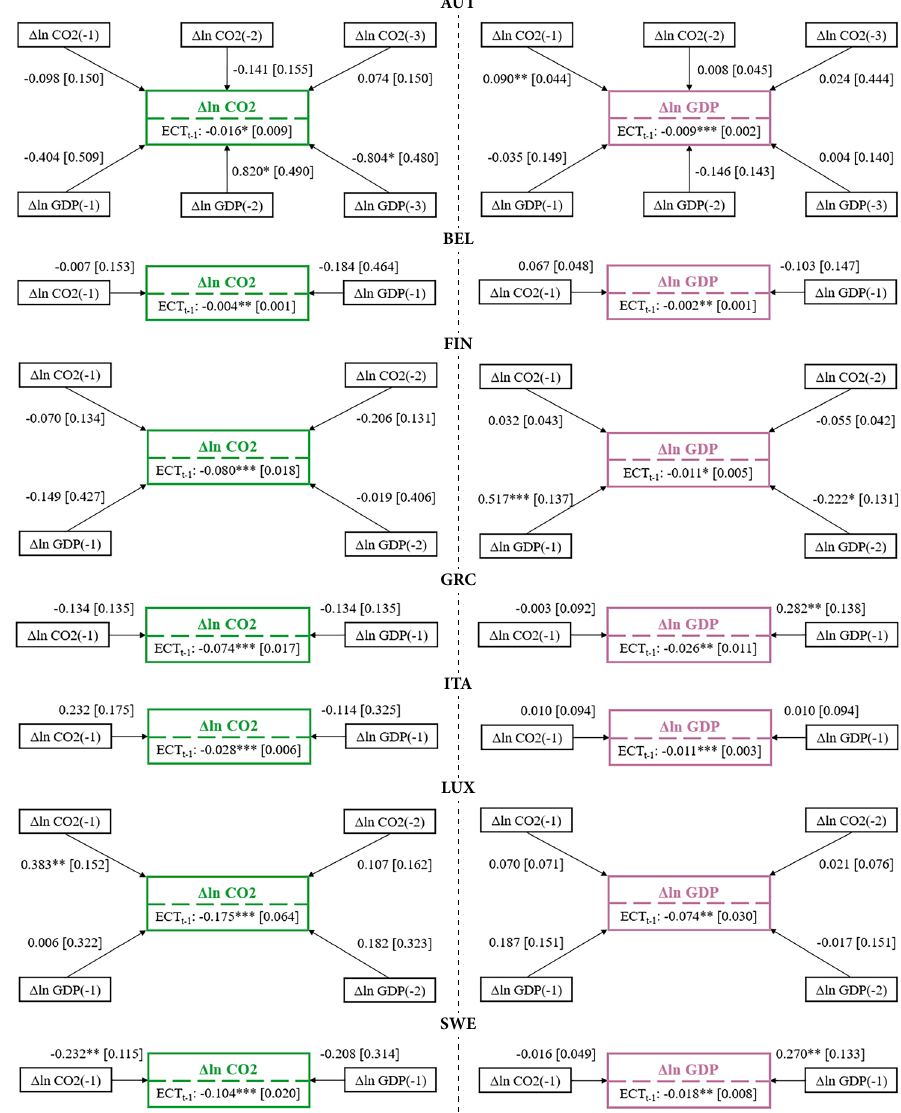
Figure 5. Granger causality test results – linear